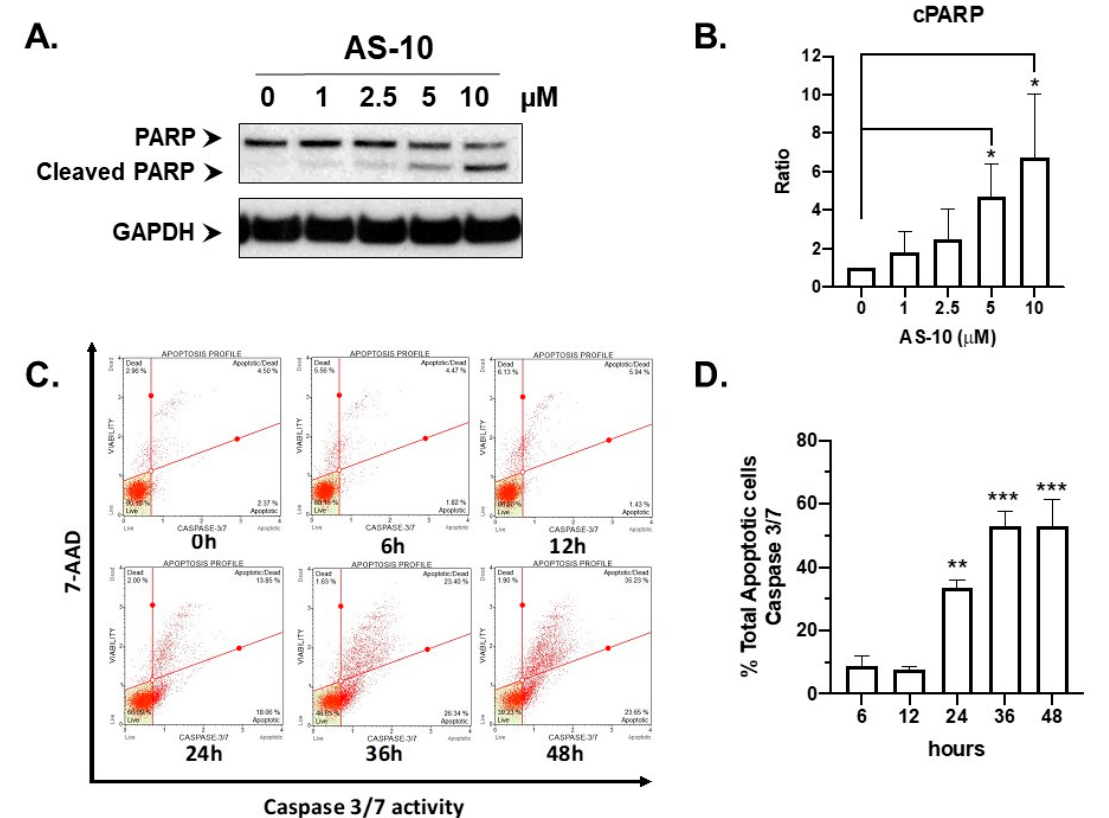
Figure 2. AS-10 induced caspase activation and apoptosis in Panc-1 cells. ( A ) Western blot analysis of PARP cleavage activation. Panc-1 cells were treated with different concentrations of AS-10 for 24 h before whole-cell lysates were prepared for blotting with PARP antibody. GAPDH protein was probed as the loading control. ( B ) Densitometry analysis of cleaved PARP (cPARP) normalized to the house keeping protein evaluated by Image J. Data represented as the means ± SD of three independent experiments, * ( p < 0.02). ( C ) Illustrative examples of Muse caspase 3/7 activity time course outcomes. Panc-1 cells were treated with 5 µM AS-10 for the indicated duration. Bottom-left quadrant represents healthy cells; bottom-right quadrant represents early apoptotic cells (Caspase 3/7 (+) and 7-ADD (-)); top-right quadrant represents late apoptotic/dead cells (Caspase 3/7 (+) and 7-ADD (+); Top-left quadrant represents cells that died of necrosis (Caspase 3/7 (-) and 7-ADD (+). ( D ) Total apoptotic cells (early + late apoptotic cells) measured by Muse caspase 3/7 activity assay as a function of exposure duration to 5 µM AS-10. Data represented as the means ± SD of three independent experiments, ** ( p < 0.01), *** ( p < 0.001).